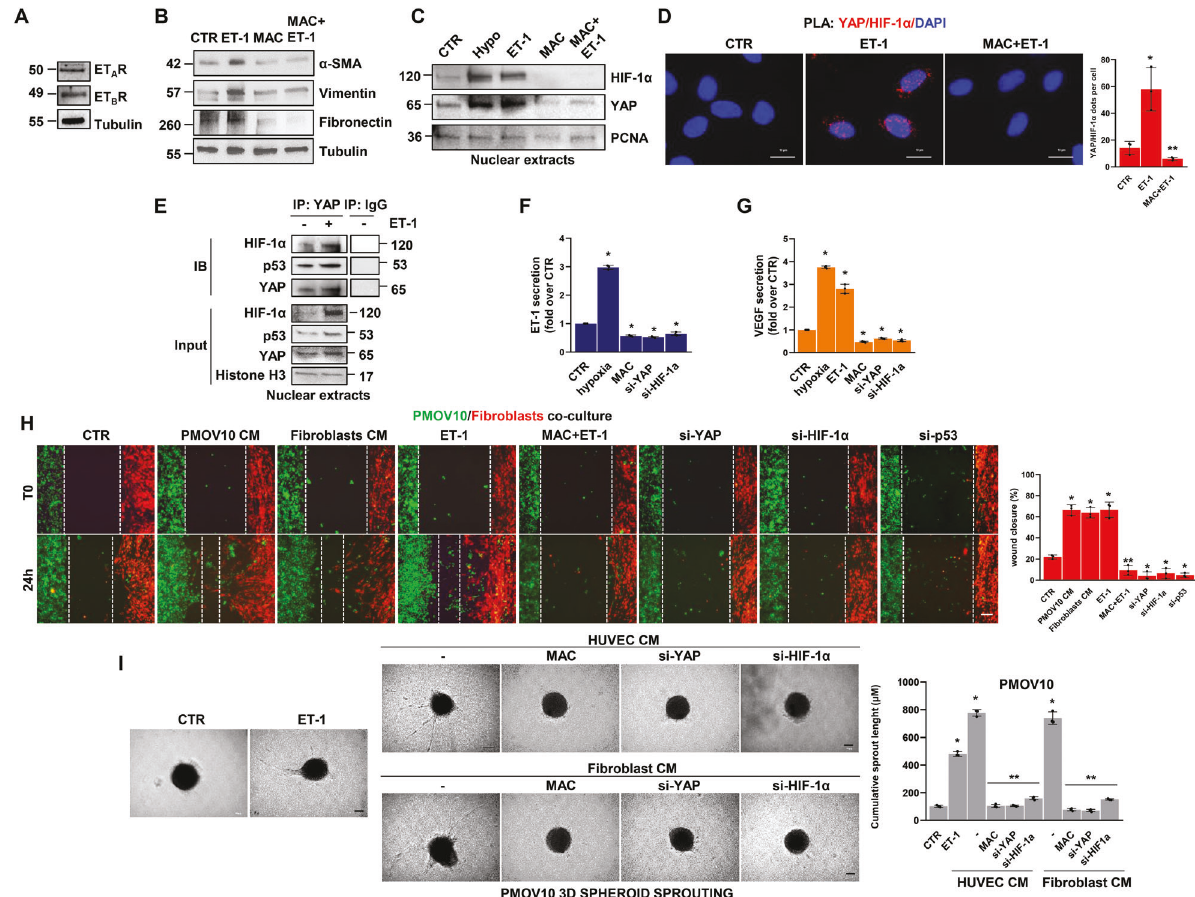
extracts of fi broblasts stimulated with ET-1 and/or MAC for 24 h. Tubulin is used as a loading control. C IB analysis of YAP and HIF-1 α protein expression in nuclear extracts of fi broblasts stimulated with ET-1 and/or MAC or hypoxia for 2 h. PCNA was used as a loading control. D Representative images of PLA detection of protein complexes containing YAP and HIF-1 α (red signals) in ET-1-stimulated fi broblasts and/or treated with MAC for 2 h. Nuclei are stained in blue (DAPI). (scale bar: 10 µm, magni fi cation 64X). The right graph shows the PLA quanti fi cation. Bars are means ± SD (* p < 0.02 vs. CTR; ** p < 0.006 vs. ET-1; n = 3). E Nuclear extracts of fi broblasts stimulated with ET-1 for 2 h were IP for YAP using anti-YAP or anti-IgG and IB using anti-YAP, anti-p53 and anti-HIF-1 α . Histone H3 represents the loading control. Representative images of